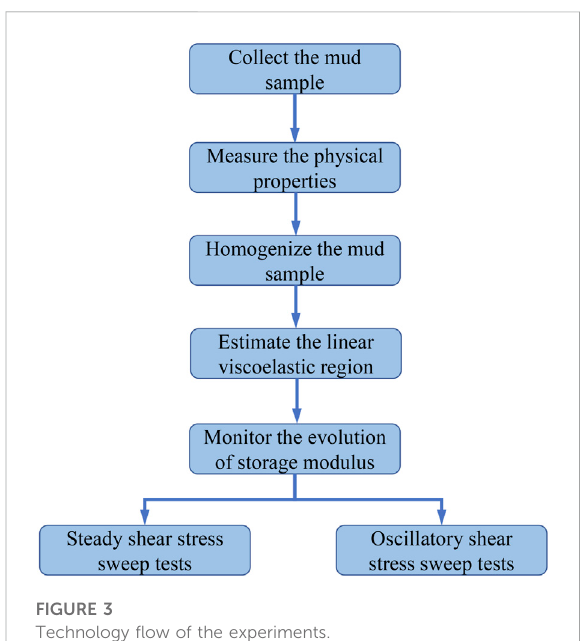
FIGURE 3 Technology fl ow of the experiments.